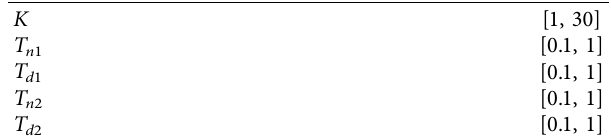
Table 1: Variation range of